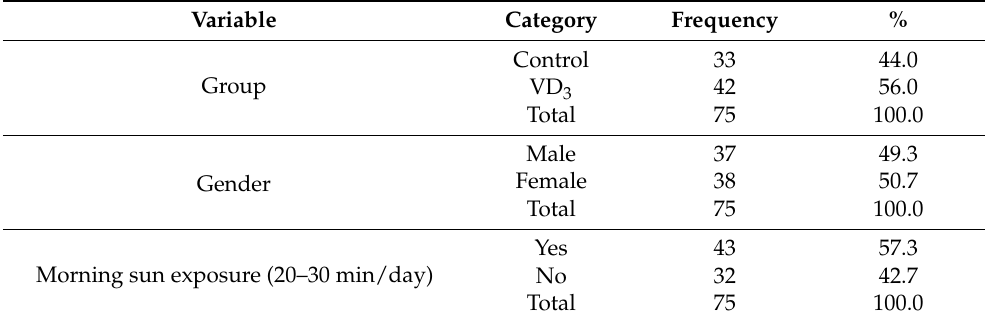
Abbreviations: VD 3 , VD 3 supplementation